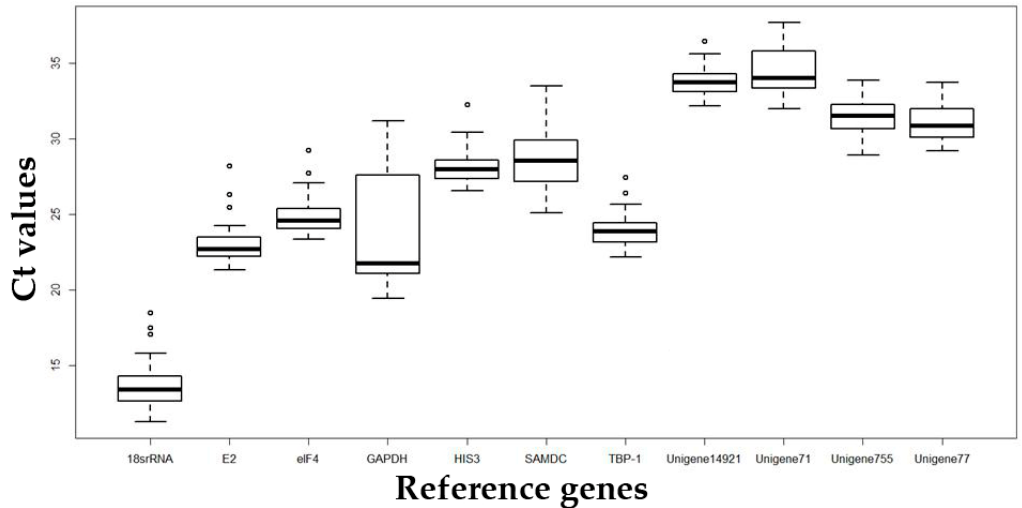
Figure 3. qRT-PCR C t values for all candidate reference genes in annual ryegrass leaf samples under various abiotic stress conditions. Variation is displayed as medians (lines), 25th to 75th percentiles (boxes), and ranges (whiskers).